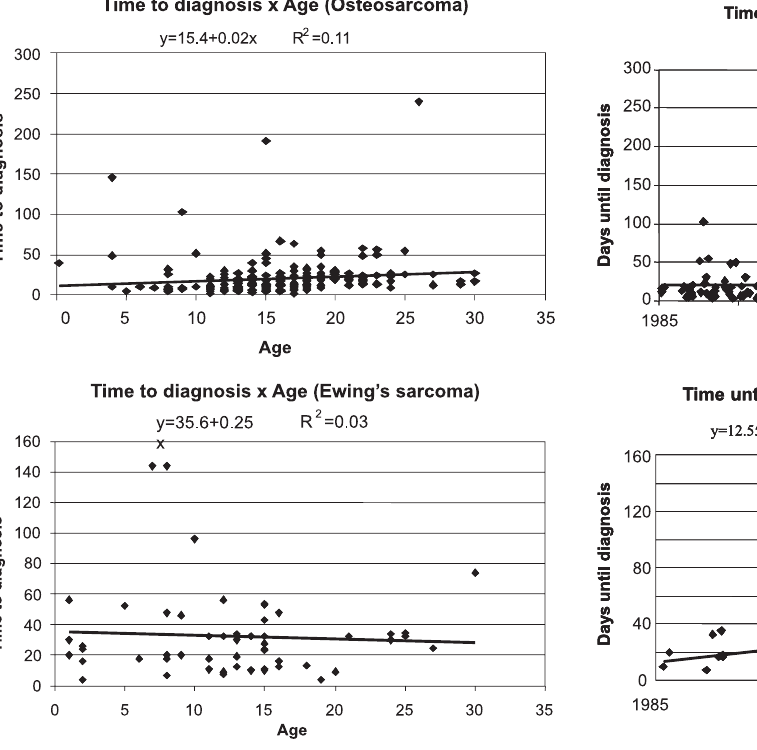
Figure 2 - Comparative analysis of the time until diagnosis and date of diagnosis in patients with Osteosarcoma and Ewing´s Sarcoma. Comparison using a two-tailed mann-whitney u-test